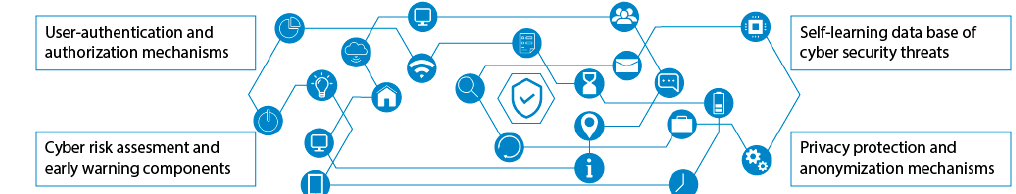
Figure 4. DRIvE cyber-security approach.